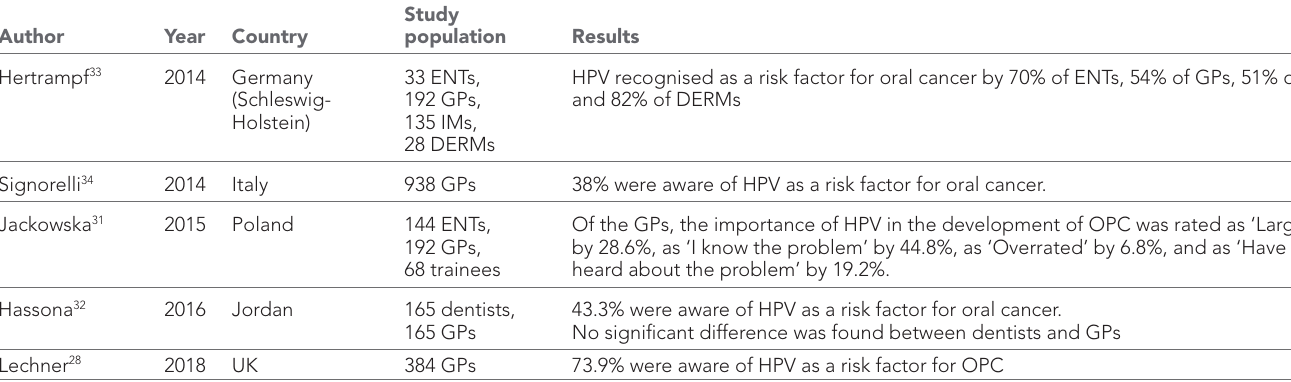
Table 5 Overview and results of published studies reporting on awareness of HPV in the development of head and neck cancers among GPs and other healthcare professionals